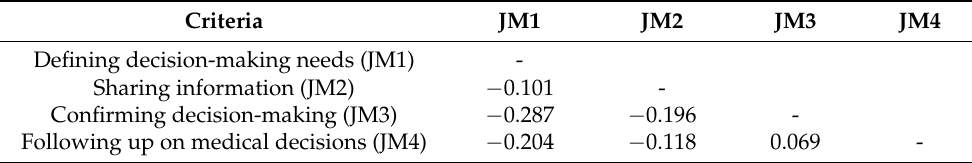
Table 16. The net influence matrix of the joint information and decision making (JM) aspect. Criteria JM1 Defining decision-making needs (JM1)